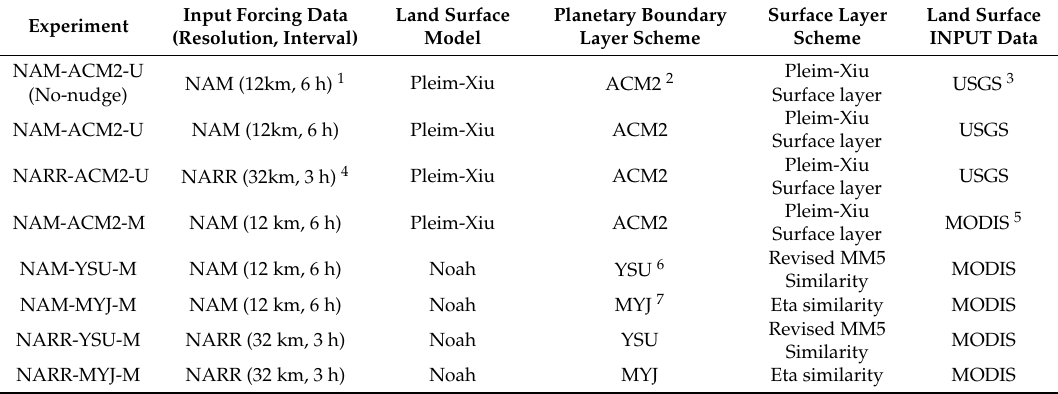
Table 1. Summary of physics options, large-scale forcing datasets, and land-use classification datasets used in the WRF (version 3.7.1) sensitivity